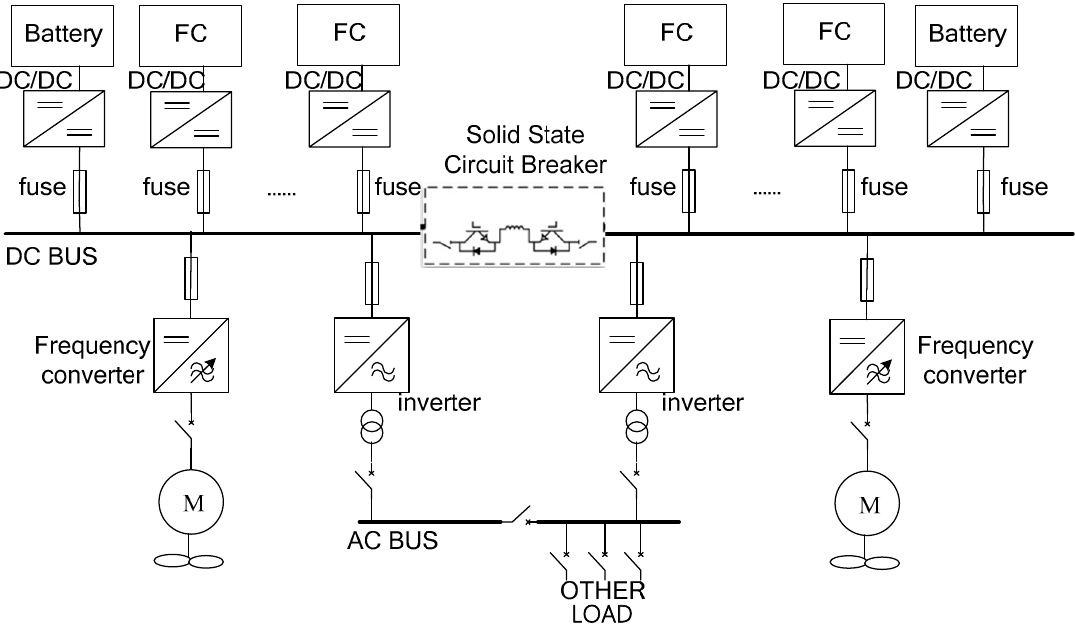
Figure 4. Single line drawing of the pilot project in China.